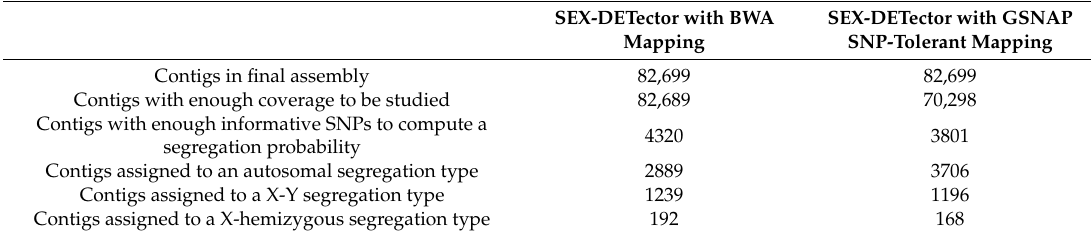
Table 2. Results of the SEX-DETector pipeline on the C. grandis dataset. Number of contigs assigned by SEX-DETector to an autosomal, X / Y or X-hemizygous segregation type before and after SNP-tolerant